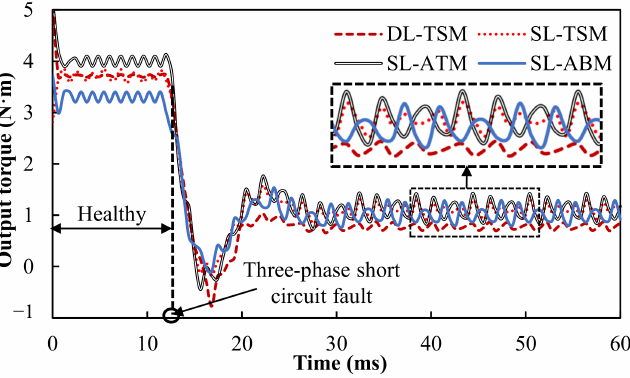
Figure 15. Output torque waveform of the machines when other healthy phases work normally after three-phase short circuit occurs at 1000 r/min.